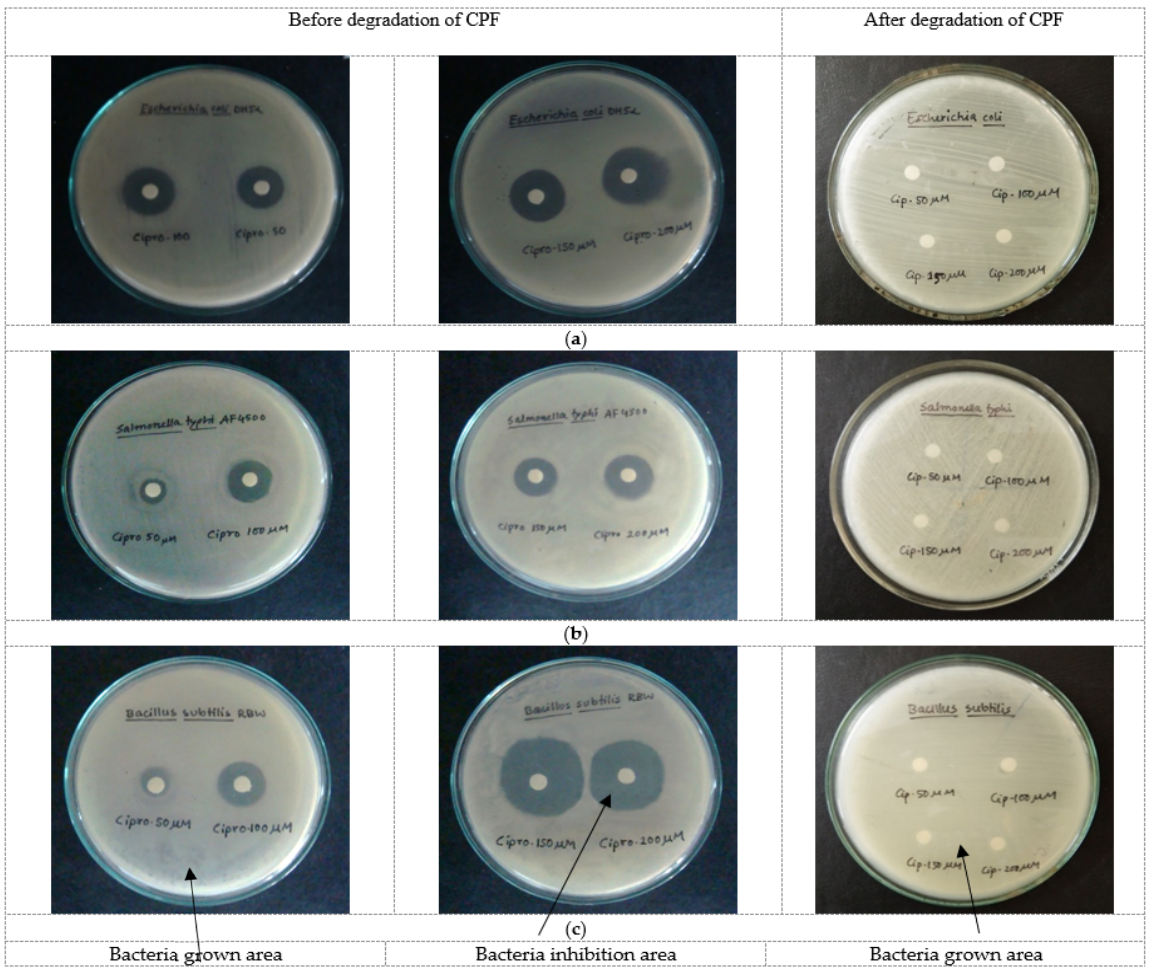
Figure 14. Antimicrobial activity of CPF (from left to right: 50, 100, 150, and 200 µM) against ( a ) Escherichia coli DH5 α , ( b ) Salmonella typhi AF4500 and ( c ) Bacillus subtilis RBW bacteria before and after solar light-assisted oxidative treatment with Fe III -CS-GLA/H 2 O 2 in aqueous solution. Table 3. Antibacterial activities of CPF before and after catalytic degradation with Fe III -CS-